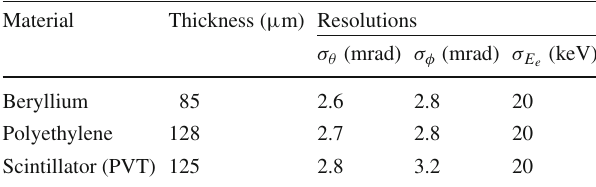
Table 2 Angle and energy uncertainties introduced by material effects in the target, for different target materials. A 76 ◦ slant angle is assumed. The chosen thickness is the one providing 90% muon stopping power